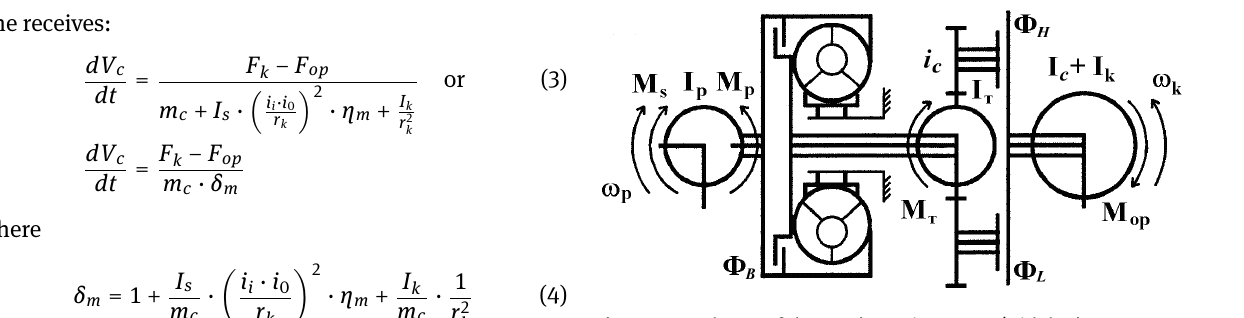
Figure 2: A scheme of the car dynamic system (with hydro-